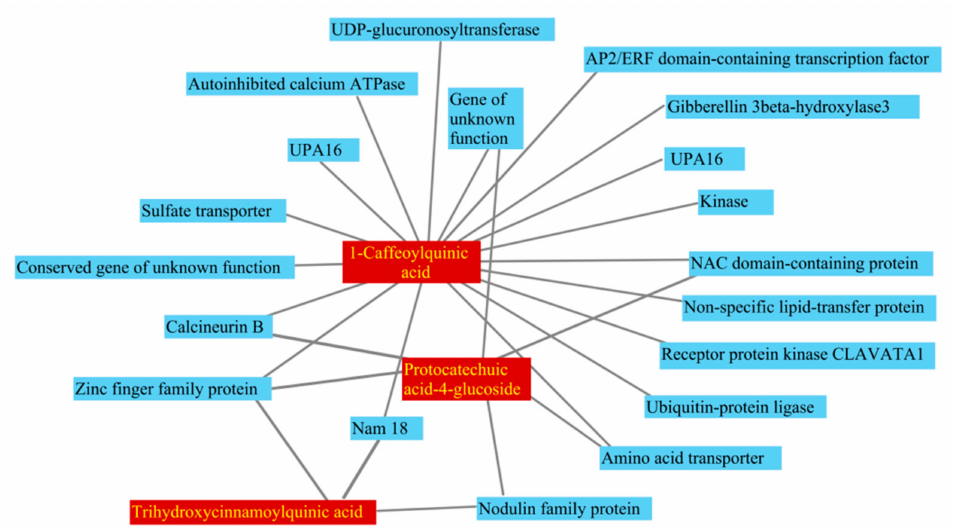
Figure 5. Network of long-distance transport mRNAs and metabolites related to early maturity: the coefficients of determination between long-distance transport mRNAs and metabolites are greater than